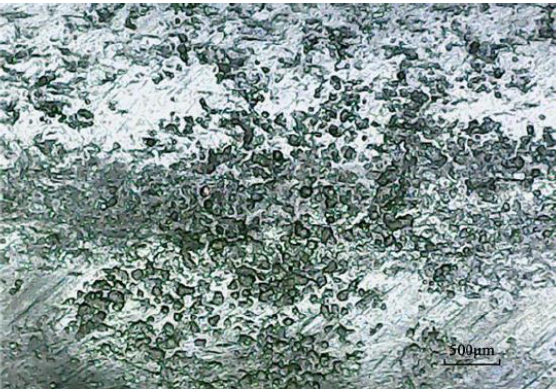
Figure 7. Typical corrosion pit on the surface of steel after pickling.